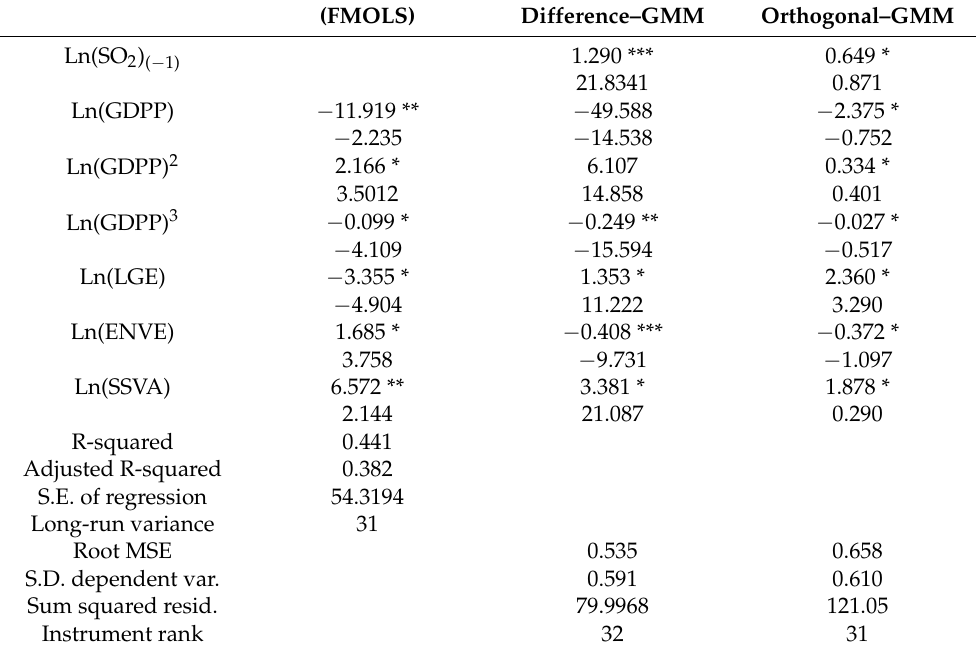
Table 4. Results for the second-stage estimation using sulfur dioxide (SO 2 ) as the dependent variable.